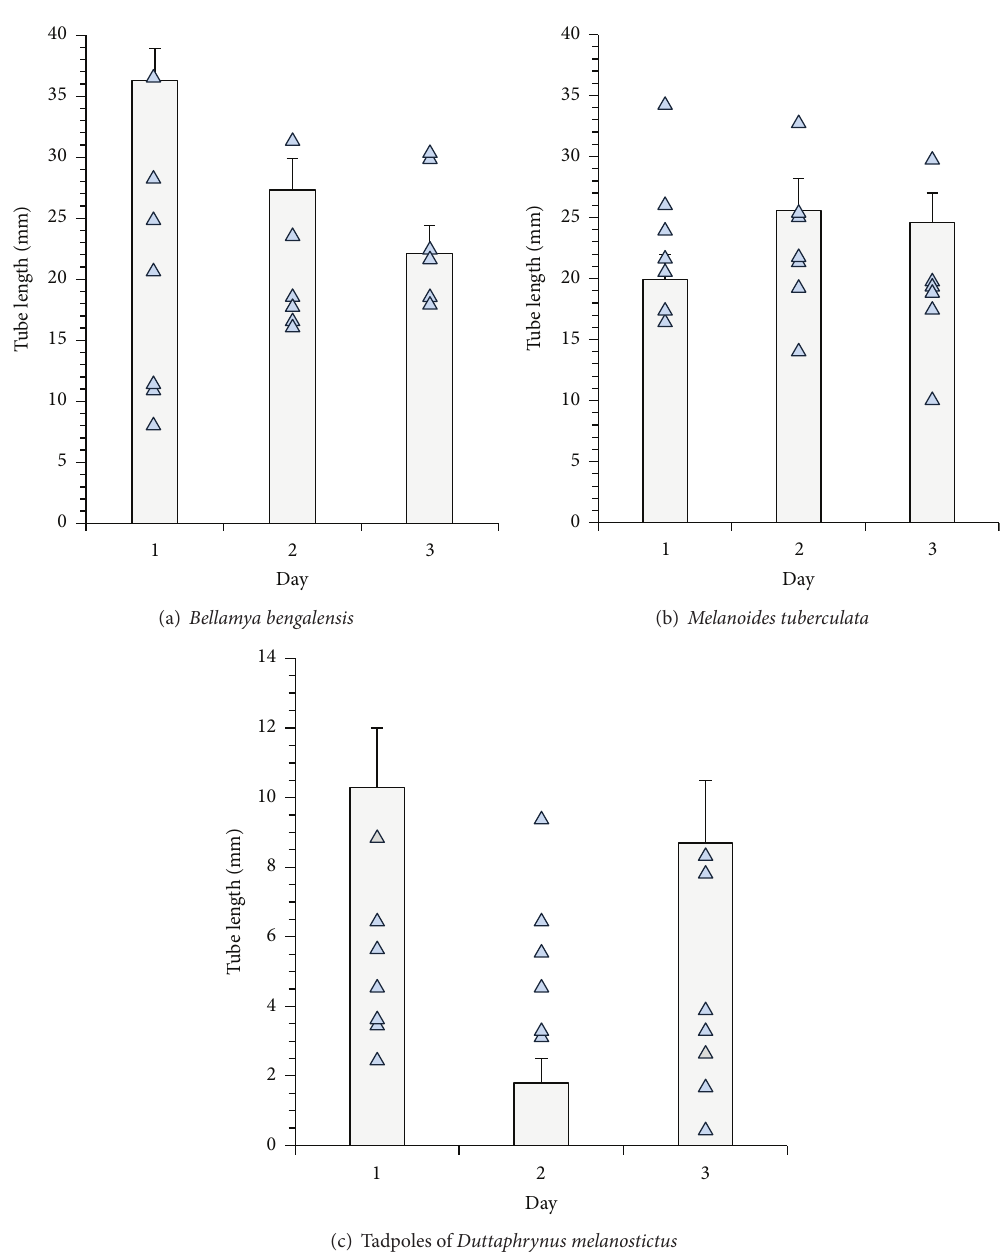
Figure 4: Changes in mean tube length of the developing chironomid larvae in the quadrats in the presence of snails and tadpoles (filled triangles) and control (without non-predators, bar)